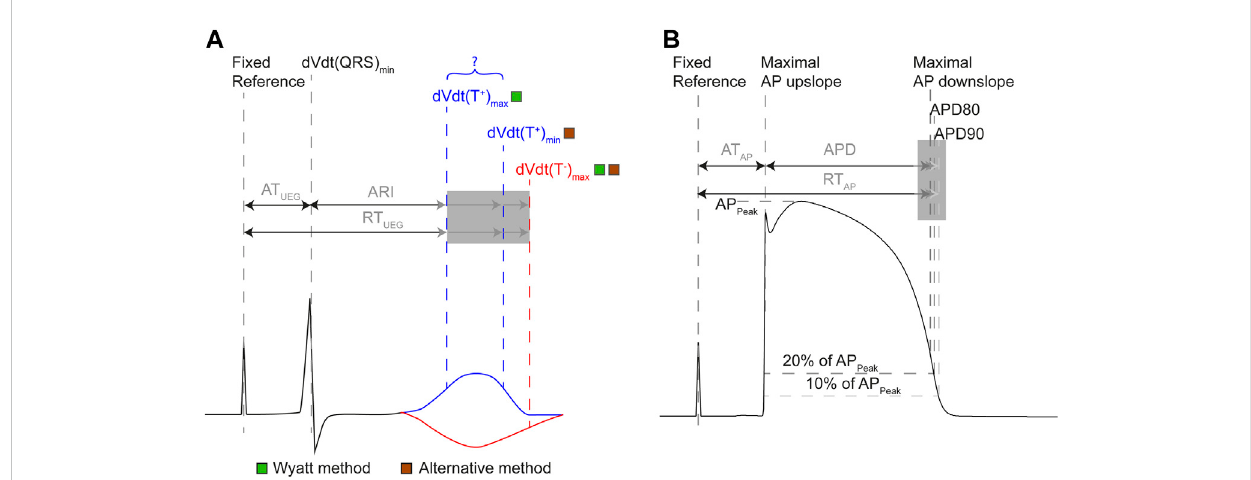
FIGURE 2 De fi nitions of terms related to the intracardiac UEG (A) and action potential (B) . (A) AT in the UEG is measured from a fi xed reference point (e.g., a common pacing spike)untilthe steepestdownslopeof thelocalQRScomplex.RTismeasured fromthesame reference, but itsend isde fi ned differently throughout literature. The activation-recovery interval (ARI) is equal to the subtraction of AT from RT. The Wyatt method of determining RT and ARI uses the maximum upslope of the UEG T-wave, regardless of polarity. The alternative method uses the maximum downslope of the T-wave for positive T-waves,andthemaximumupslopefornegativeT-waves. (B) Intheactionpotential,ATisde fi neduniformly:from fi xedreferencepointuntilthesteepest upslope of the action potential (AP). Action potential duration should re fl ect the same interval as the ARI, but is de fi ned heterogeneously throughout literature (e.g., as the point in time where the cell has repolarized for 80% (APD80), for 90% (APD90), or the TMP reached its maximum downslope). RT in the action potential is measured from the same reference as AT, but its end has been de fi ned differently (analogous to APD de fi